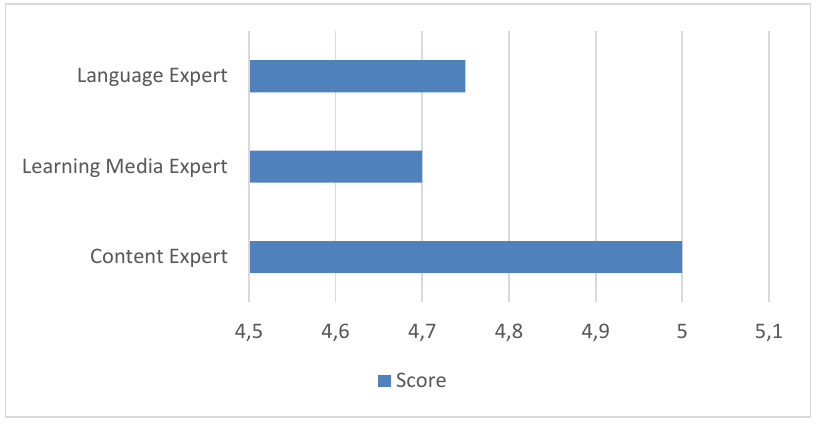
Figure 5. Validation Results